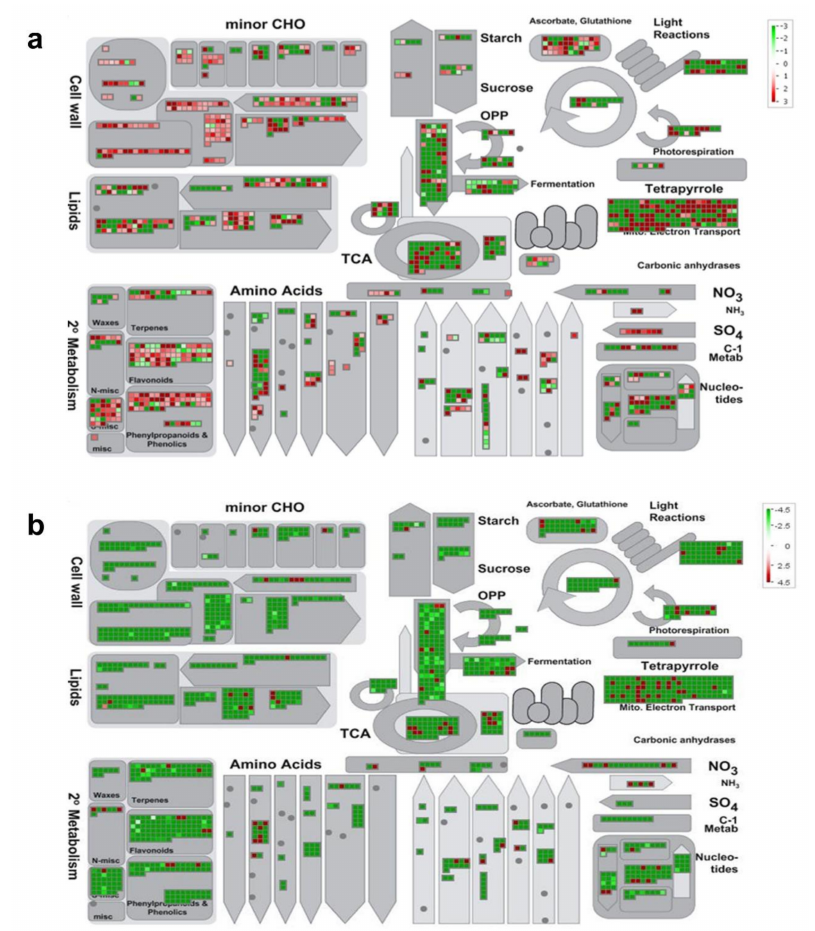
Figure 4. MapMan metabolic overview of aluminum-stress-responsive genes in sugarcane cultivars ( a ) TAS and ( b ) SAS. The analysis was performed using MapMan v.3.5.0. Small squares represent Log2 expression values of stress-responsive genes. The color key represents the RPKM (reads per kilobase million)—normalizes Log3-transformed counts. Red represents the upregulated and green the downregulated genes in response to aluminum